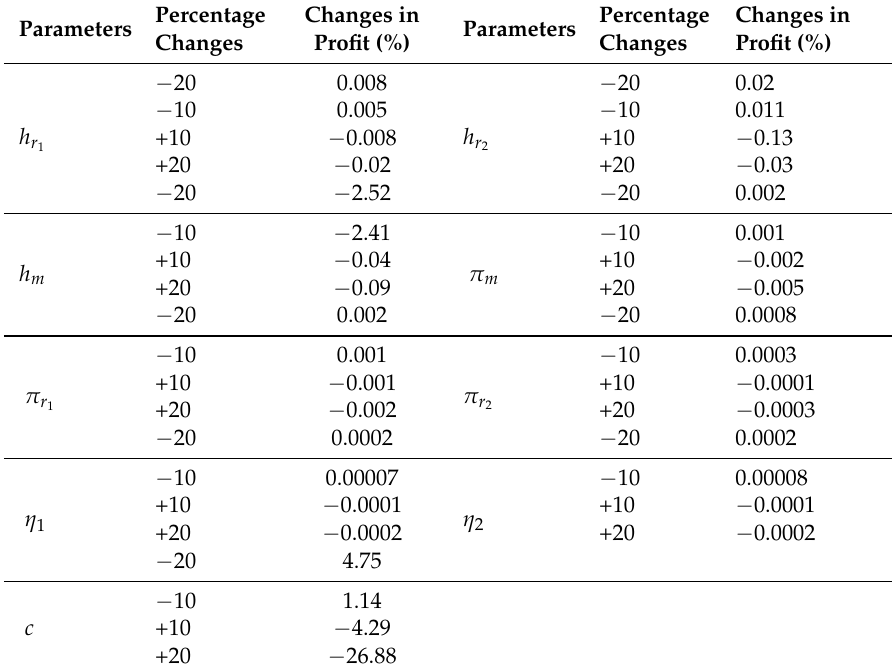
Table 8. Sensitivity analysis of the key parameters of Example